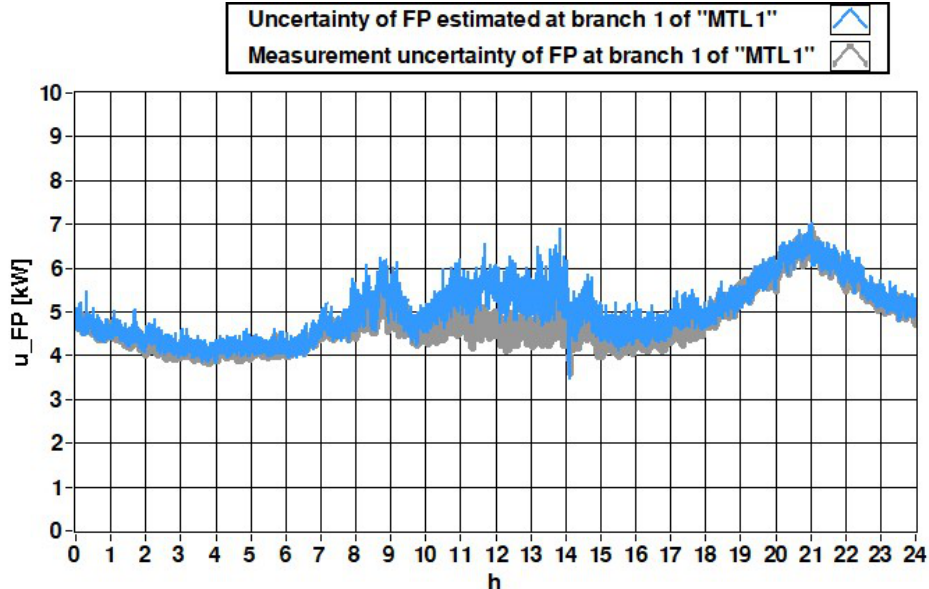
Figure 13. Comparison between the measurement and the calculated uncertainties in the active power